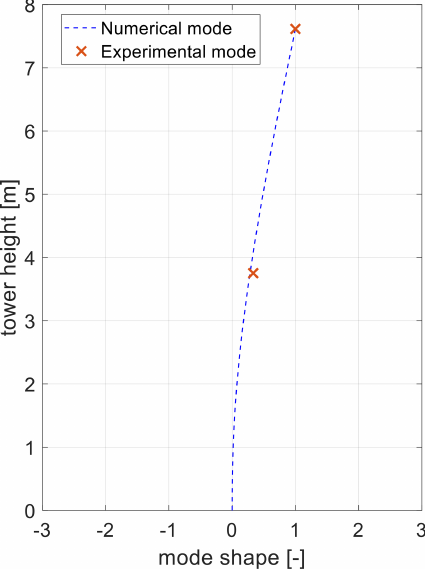
Figure 8. Experimental and numerical modal